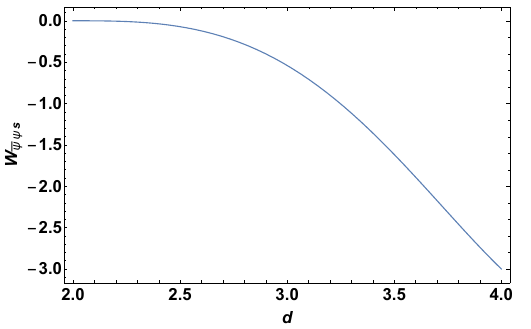
(defined in eq. 5.4), as a function ψψs ( d = 2) = 0 and ψψs